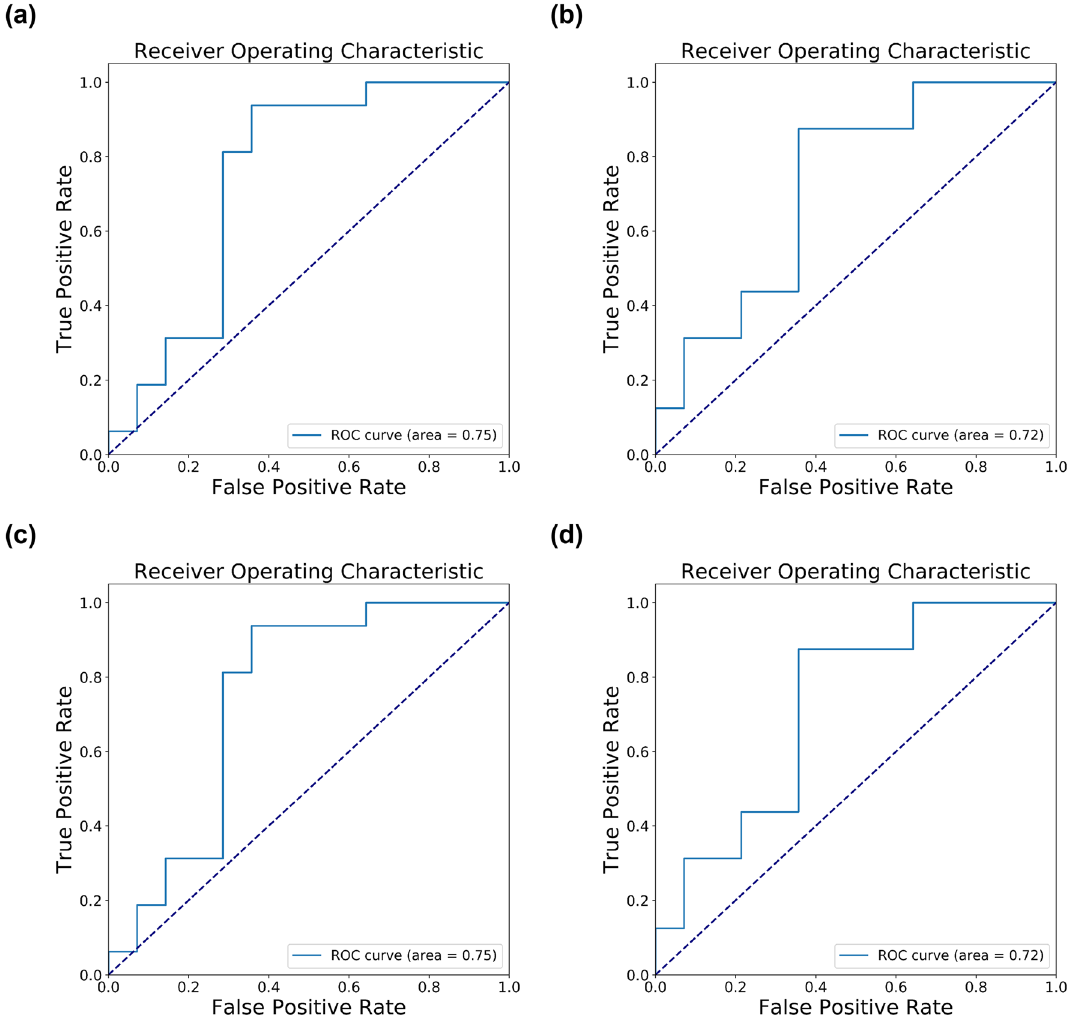
Figure 2. The ROC curve of the test set with transcriptome data only. ( a ) All features (44,608) + SVM (rbf). ( b ) Chi-squared test (35) + SVM (rbf). ( c ) All features (44,608) + SVM (rbf), with noise ( I = 0.001) and probability threshold = 0.3. ( d ) Chi-squared test (35) + SVM (rbf), with noise ( I = 0.001) and probability threshold =